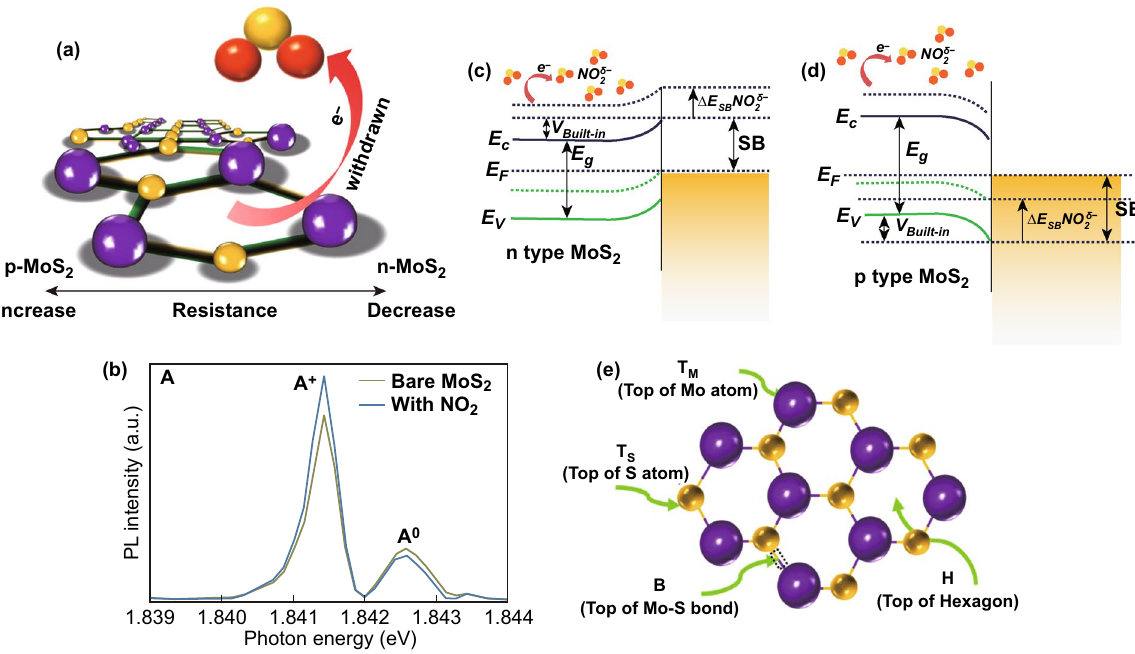
Fig. 5 a Schematic interaction of NO 2 gas molecules with the n-type or p-type MoS 2 layer. NO 2 captures the electrons from MoS 2 layer. b Effect of NO 2 molecules adsorption on PL spectra. The spectral weight of positively charged trions is increased on the cost of excitons spectral weight in n-type MoS 2 . Reproduced with permission from Ref. [32]. Copyright (2015) American Chemical Society. Schottky barrier height modulation after NO 2 molecules adsorption in c n-type MoS 2 d p-type MoS 2 . e Four possible NO 2 adsorption sites on MoS 2 . Reproduced with permission from Ref. [255]. Copyright (2017) AIP